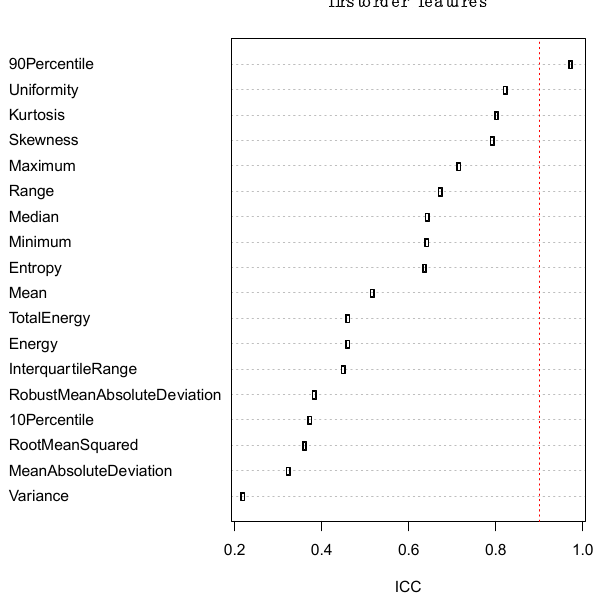
Figure 3. Robustness of first-order histogram features across segmentations. The vertical dashed red line indicates the ICC > 0.9 threshold. Pyradiomics provides 18 first-order features. The robustness (ICC) is above 0.8 only for skewness, kurtosis, uniformity and 90 percentile. The latter has ICC > 0.90. They are not dependent on bin-width (only entropy has slight dependence). Because they are first-order, they are not dependent on distance, neither do they depend on resolution or interpolator.